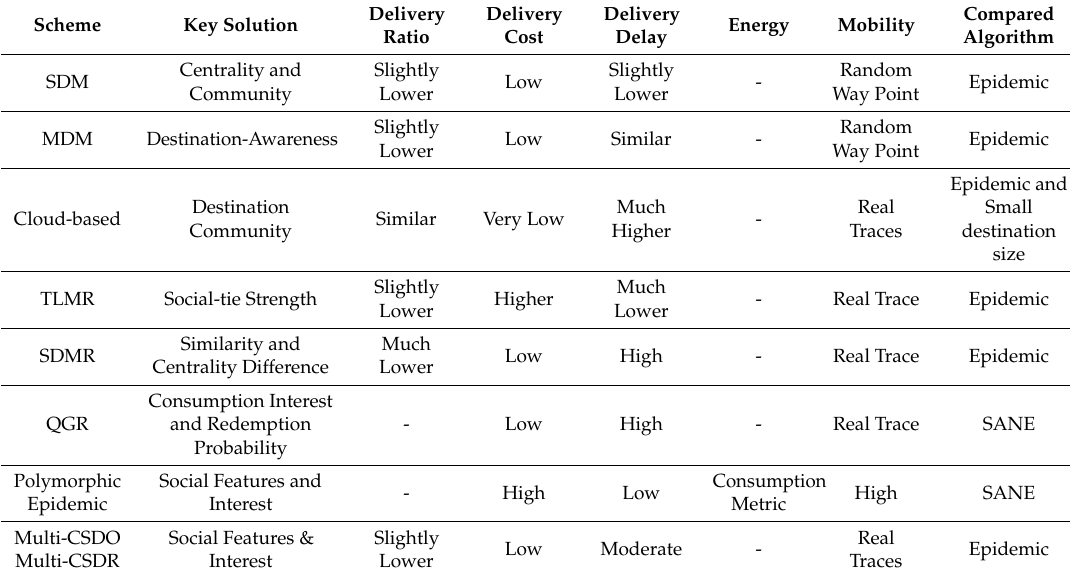
Table 1. Performance comparison of social-aware multicast routing in